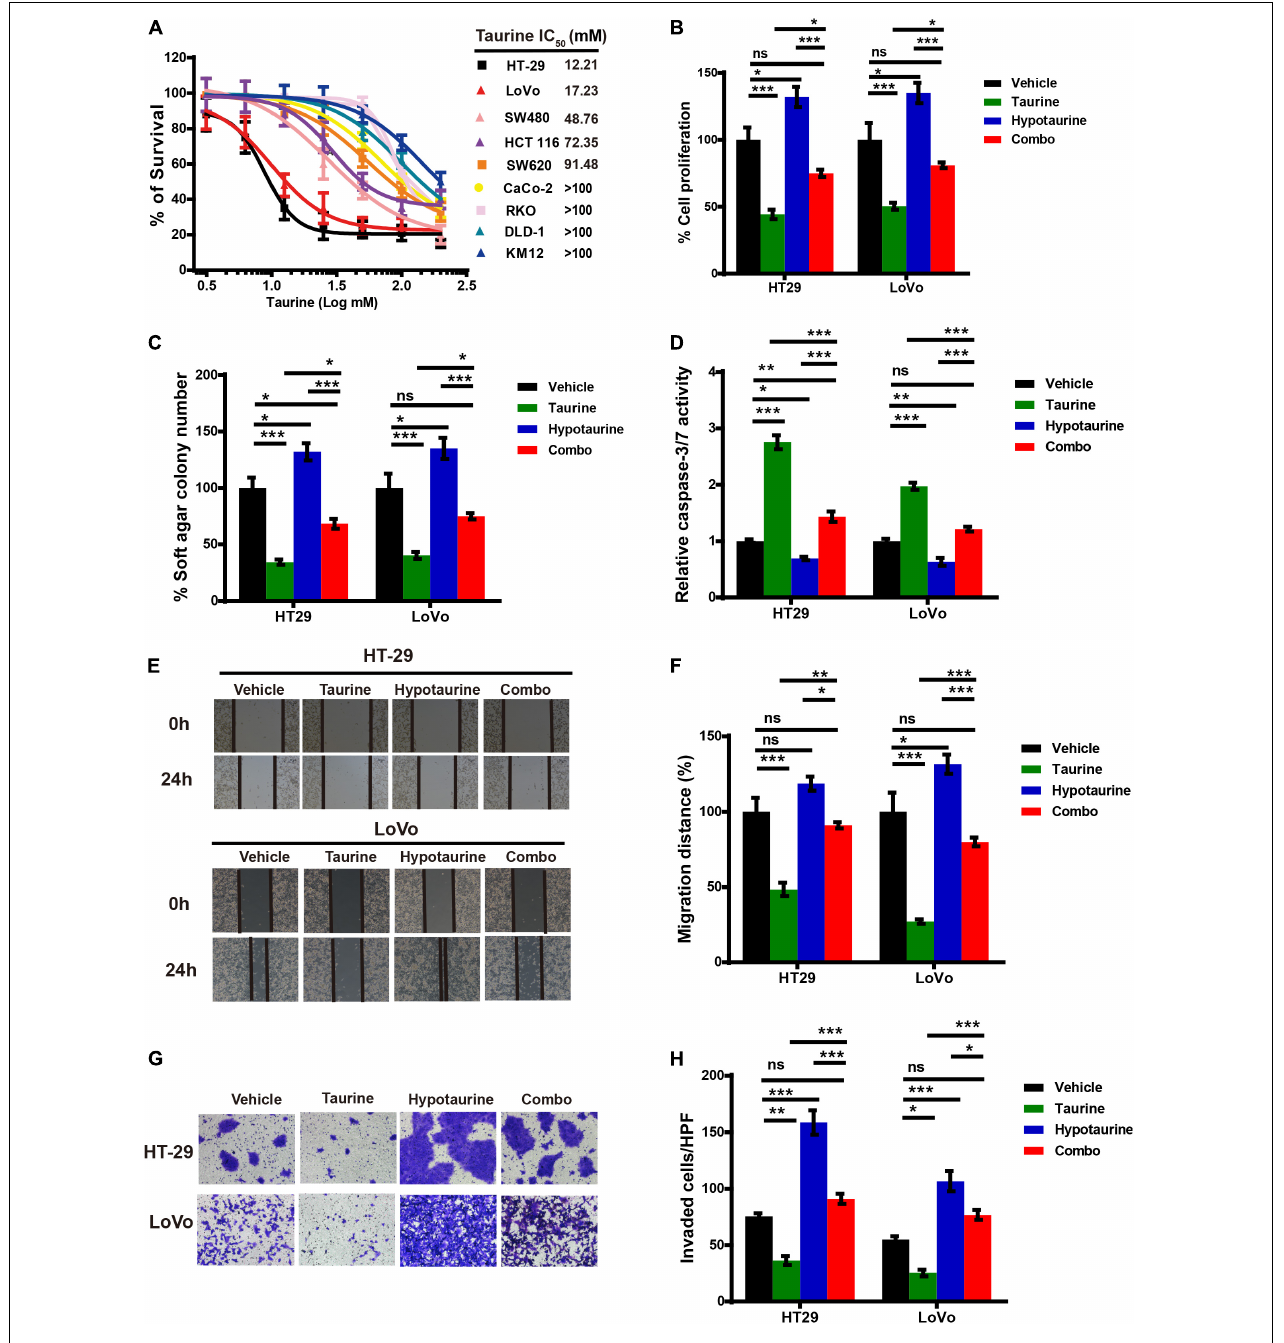
FIGURE 3 | Taurine reverses the promoting effects of hypotaurine on CRC progression. (A) The viability of CRC cell lines cultured for five days in serial concentrations of taurine, and each IC50 value were shown by Alamar Blue assay (means ± SEM). (B) The proliferative rate of CRC cell lines after treatment with taurine (10 mM) and/or hypotaurine (10 mM) (means ± SEM) (one-way ANOVA followed by Tukey’s post hoc test, * P < 0.05, *** P < 0.001). (C) Quantification of clones formed by the indicated CRC lines after treatment with taurine (5 mM) and/or hypotaurine (5 mM) for 3 weeks (means ± SEM) (one-way ANOVA followed by Tukey’s post hoc test, * P < 0.05, *** P < 0.001). (D) The proapoptotic effects of taurine (10 mM) and/or hypotaurine (10 mM) on CRC cells were detected by caspase 3/7 reporter assay (means ± SEM) (one-way ANOVA followed by Tukey’s post hoc test, * P < 0.05, ** P < 0.01, *** P < 0.001). (E,F) The cellular migratory effects of taurine (10 mM) and/or hypotaurine (10 mM) in CRC cells were evaluated by wound-healing assay and quantified. (means ± SEM) (one-way ANOVA followed by Tukey’s post- hoc test, * P < 0.05, *** P < 0.001). (G,H) The cellular invasive effects of taurine (10 mM) and/or hypotaurine (10 mM) in CRC cells were assessed using the transwell invasion assay and quantified (means ± SEM) (one-way ANOVA followed by Tukey’s post hoc test, * P < 0.05, ** P < 0.01, *** P < 0.001).